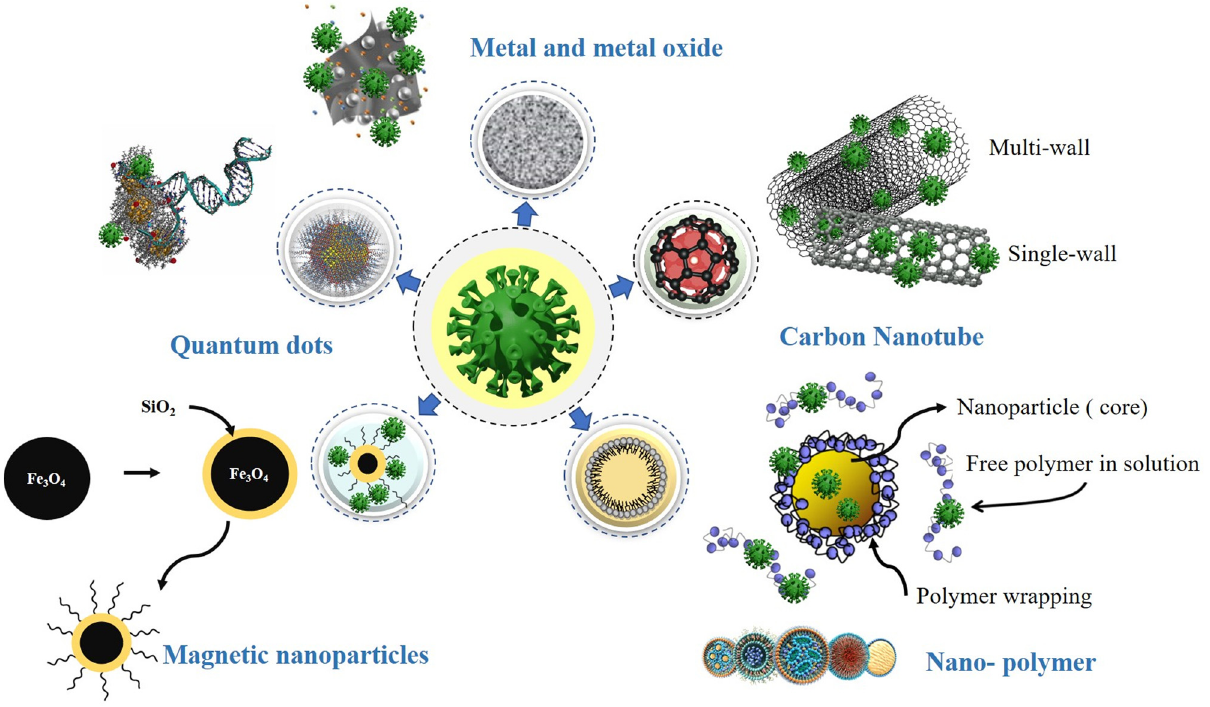
Figure 12: Nano - adsorbents for virus removal from